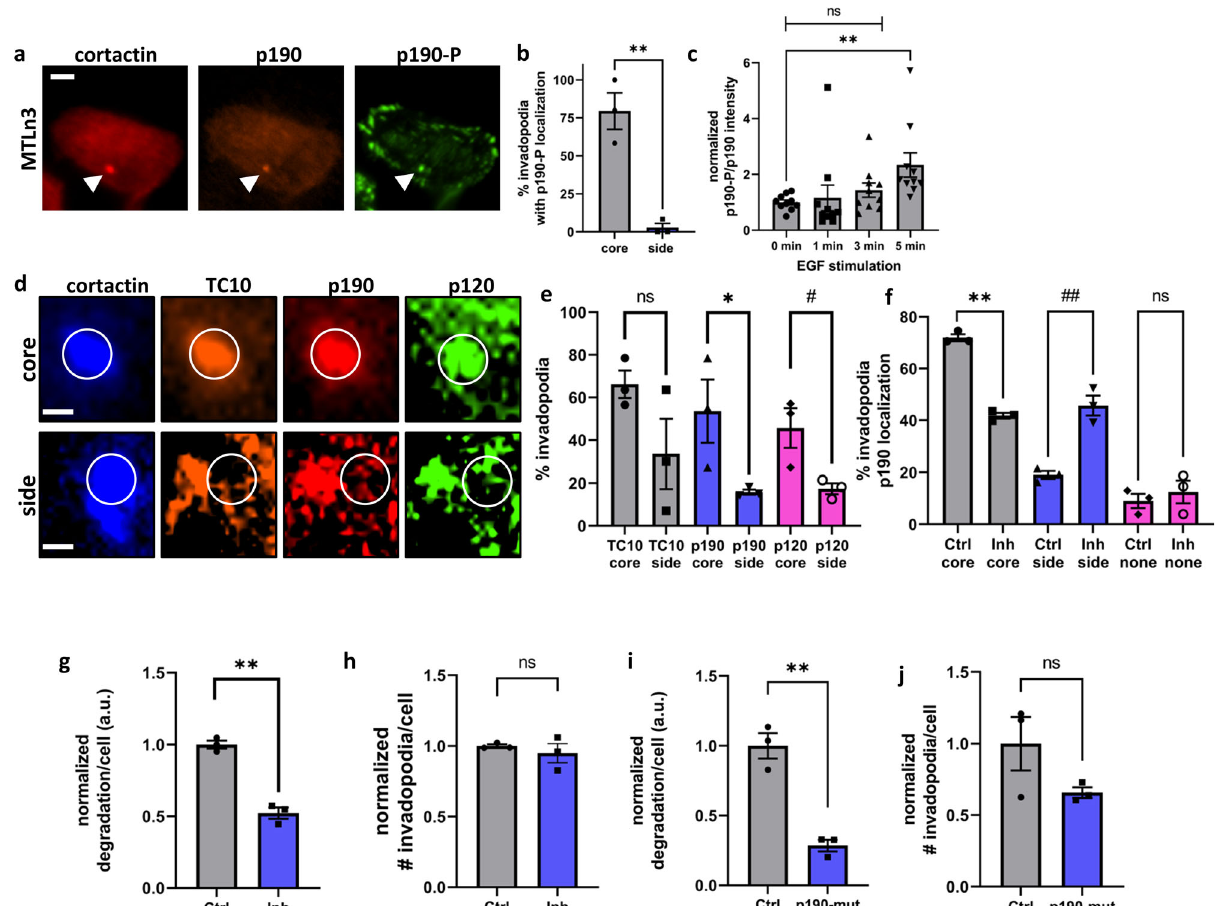
Fig. 6 Tyrosine phosphorylation of p190RhoGAP is required for matrix degradation. a Representative, immunostaining for endogenous p190RhoGAP and Y1105-phosphorylated p190RhoGAP, co-expressed with mtagRFP-T-cortactin as an invadopodia marker. White bar = 5 µ m. b Quanti fi cation of the percentage of invadopodia that were positive for phosphorylated p190RhoGAP colocalization. Student ’ s t-test, two-tail analysis: ** p = 0.0001518; n = 3 experiments, shown with SEM. c The ratio of phosphorylated p190RhoGAP to total p190RhoGAP at invadopodia in MTLn3 cells during invadopodia precursor formation, induced by 5 nM EGF treatment following starvation for the indicated times. Results are normalized to the ratio at 0 min. Student ’ s t - test, two-tail analysis: ns p = 0.742460426 for 0 – 1 min; p = 0.120533868 for 0 – 3 min; and ** p = 0.007470 for 0 – 5 min; n = 3 experiments, shown with SEM. d Representative, immunostaining of endogenous p190RhoGAP and p120RasGAP at invadopodia, shown together with the co-expression of fl uorescent protein-tagged WT TC10 and cortactin. White bar = 1 µ m. e Quanti fi cation of endogenous p190RhoGAP and p120RasGAP localization at either the core or the side of invadopodia. Student ’ s t -test, two-tail analysis: ns p = 0.3618 for TC10 core vs. side; * p = 0.01146 for p190 core vs. side; # p = 0.04271 for p120 core vs. side; n = 3 experiments, shown with SEM. f Quanti fi cation of the change in p190RhoGAP localization upon overexpression of the p190:p120 competitive binding inhibitor. Student ’ s t-test, two-tail analysis, ** p = 0.00006365; ## p = 0.002991; ns p = 0.5417; n = 3 experiments, shown with SEM. g Quanti fi cation of matrix degradation by MTLn3 cells when the p190:p120 competitive binding inhibitor was overexpressed. Results are normalized to the Ctrl where only the fl uorescent protein was overexpressed. Student ’ s t -test, one-tail analysis: ** p = 0.0002822; n = 3 experiments, shown with SEM. h The number of steady-state invadopodia in MTLn3 cells when the p190:p120 competitive binding inhibitor was overexpressed. Results are normalized to the Ctrl where only the fl uorescent protein was overexpressed. Student ’ s t -test, two-tail analysis: ns p = 0.5016; n = 3 experiments, shown with SEM. i Quanti fi cation of the matrix degradation by MTLn3 cells when a Y1105/1087 phosphorylation-de fi cient mutant version of p190RhoGAP was overexpressed. Results are normalized to the Ctrl where only the fl uorescent protein was overexpressed. Student ’ s t-test, one-tail analysis: ** p = 0.001009; n = 3 experiments, shown with SEM. j The number of steady-state invadopodia in MTLn3 cells when a Y1105/1087 phosphorylation- de fi cient mutant version of p190RhoGAP was overexpressed. Results are normalized to the Ctrl where only the fl uorescent protein was overexpressed. Student ’ s t-test, two-tail analysis: ns p = 0.1475; n = 3 experiments, shown with